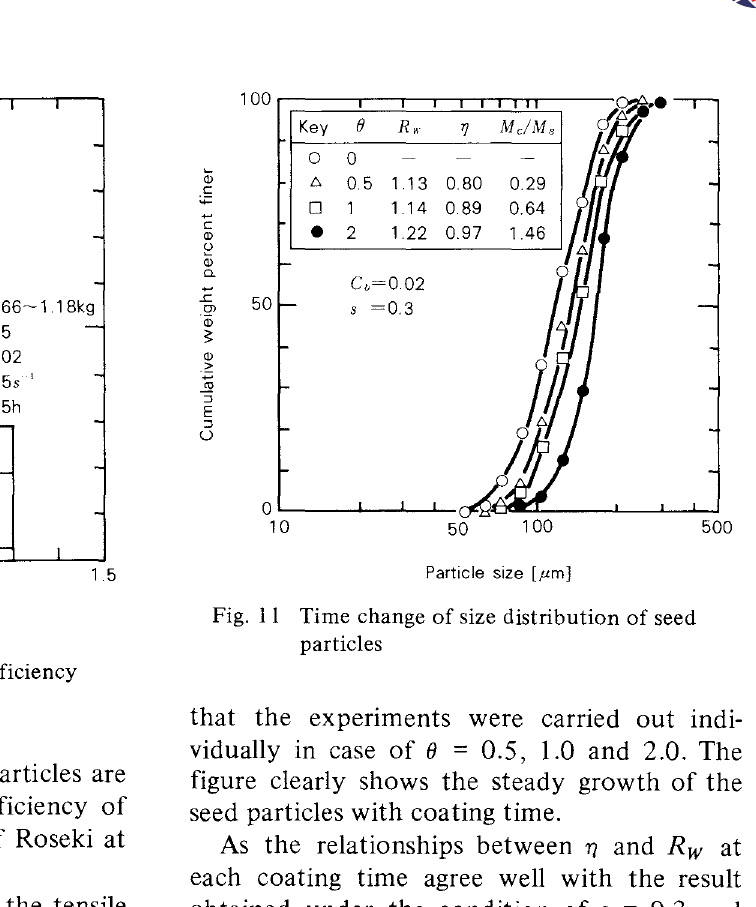
Fig. I 0 Relationship between coating efficiency and Rw